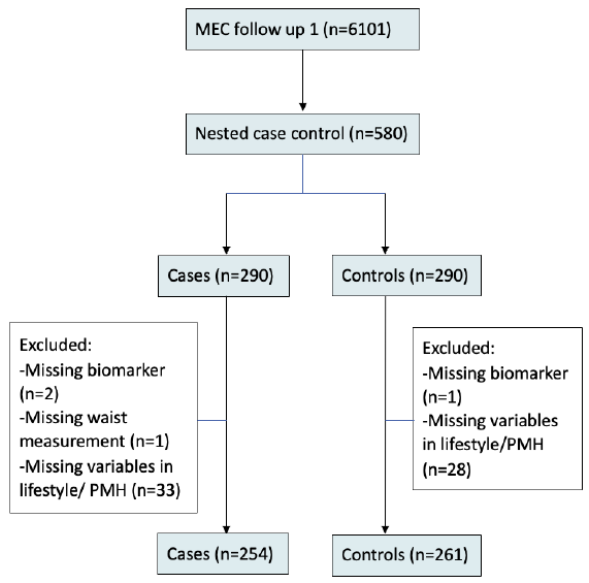
Figure 1. Flow chart of the study population. Ethics approval was obtained from the National University of Singapore Institutional Review Board. Signed informed consents were obtained from all participants by bilingual study coordinators, in the participants’ preferred language prior to